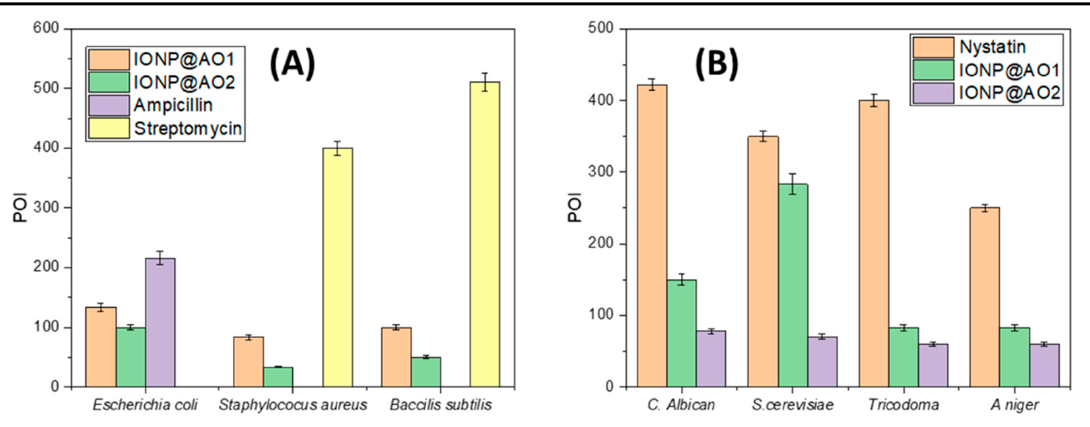
Figure 12. Percentage of inhibition (POI) of ( A ) bacterial growth and ( B ) fungal growth after treatment with IONP@AO.